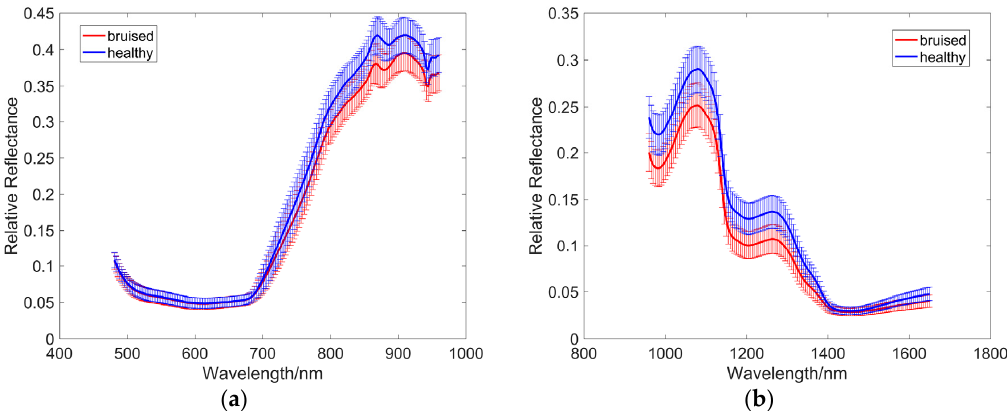
Figure 3. Mean and standard deviation spectra from ( a ) push broom based and ( b ) LCTF based hyperspectral imaging systems.